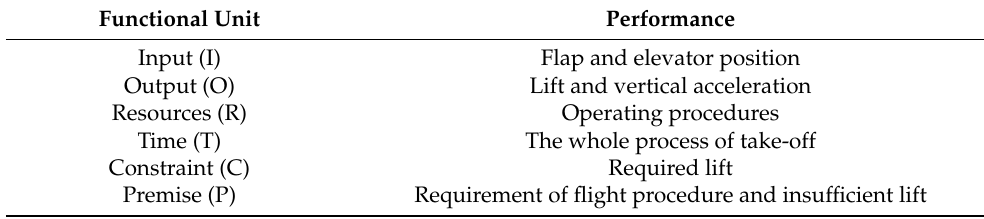
Table 3. “F3, flap, elevator” functional structure.